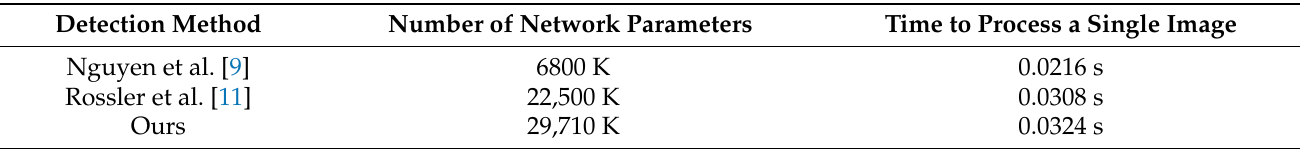
Table 10. Comparison of the number of network parameters and processing time between different methods. Detection